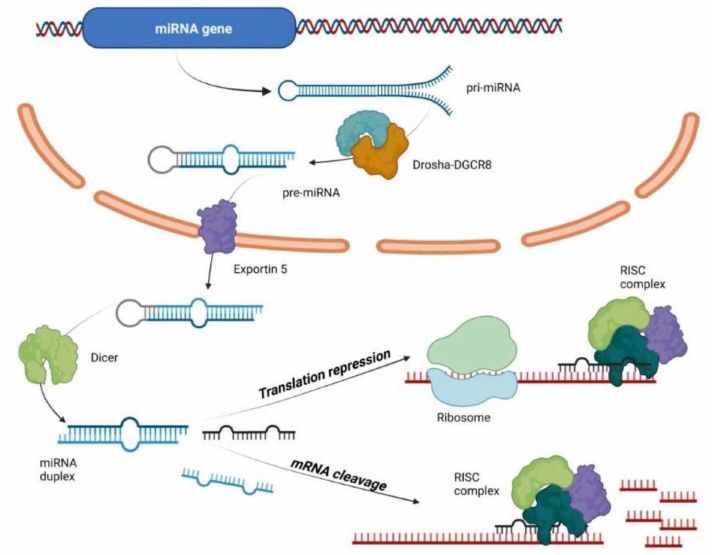
Figure 1. MicroRNA biogenesis and mechanism of action. Primary miRNAs (pri-miRNAs) are transcribed from their genes and processed into double-stranded precursors (pre-miRNAs), by the microprocessor complex: RNA binding protein DiGeorge Syndrome Critical Region 8 (DGCR8) and Drosha. Pre-miRNAs are exported to the cytoplasm by an exportin 5 (XPO5)/RanGTP complex and processed by the RNase III endonuclease Dicer yielding a mature miRNA duplex. This step is followed by unwinding of mature miRNA duplex and loading into the Argonaute2 (Ago2)- containing, RNA-induced silencing complex (RISC) where the miRNAs repress mRNAs in a sequence- specific